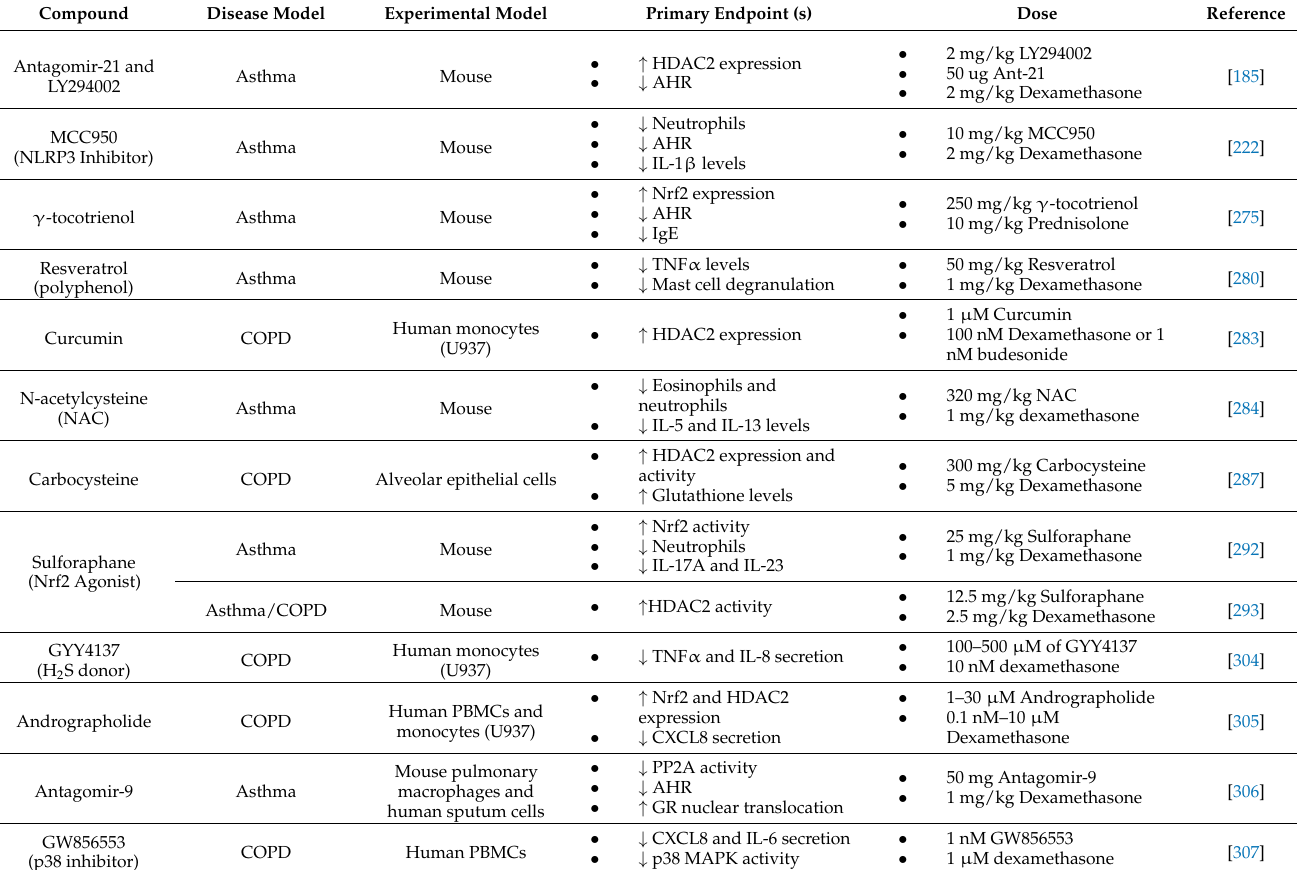
Table A1. Candidate Compounds to Improve Corticosteroid